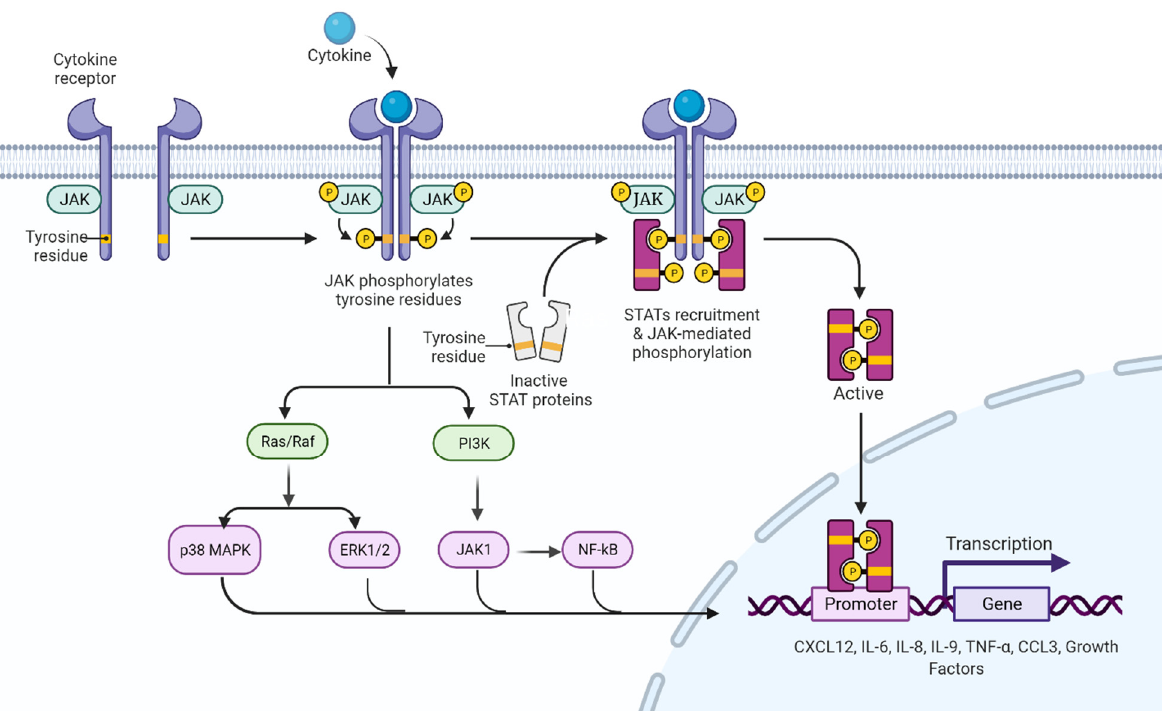
Figure 3. JAK/STAT signaling pathway. In the absence of cytokines, the JAK protein remains inactive in regions close to the intracellular domains of the receptor. When a cytokine binds to a receptor, JAK proteins and intracellular domains of the receptor are phosphorylated, activating and recruiting STAT proteins, which dimerize and translocate to the nucleus to initiate the transcription process of genes involved in cell proliferation. In addition to the activation of the JAK/STAT pathway, there is an interconnection with other intracellular signaling pathways, among the most prominent are the Ras/Raf/MAPK pathway and the PI3K pathway; the latter manifesting interconnection with JAK1 proteins, which indirectly activate the NFkB pathway, the transcriptional factors that activate the production of cytokines (among them CXCL12, IL-6, IL-8, IL-9, TNF- α and CCL3) and the growth factors identified in the inflammatory profile of individuals with chronic myeloproliferative neoplasms. JAK : Janus kinase protein; STAT: signal transducers and activators of transcription; MAPK: mitogen-activated protein kinase; PI3K: phosphoinositol kinase 3; JAK1: Janus kinase class 1 protein; NFkB: light chain nuclear factor B-cell kappa; CXCL12: chemokine 12 with CXC motif; IL-6: interleukin 6; IL-8: interleukin 8; IL-9: interleukin 9; TNF- α : tumor necrosis factor alpha; CCL3: chemokine ligand